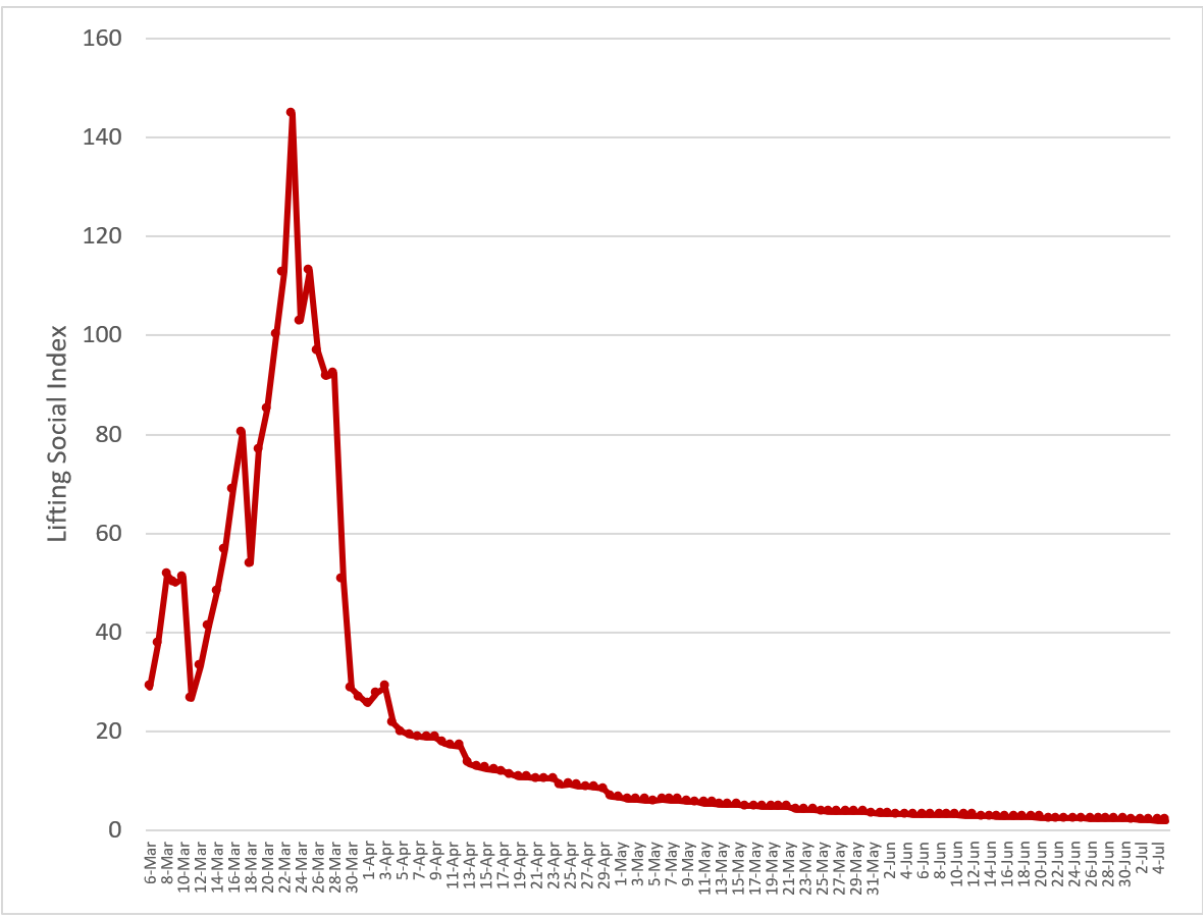
Figure 2. Temporal trend of global lifting social distancing (LSD) index up to July 5, 2020. A total of 66 countries with LSD ≥ 1 on June 28 in the pandemic phase period. The social distancing was relaxed over 4